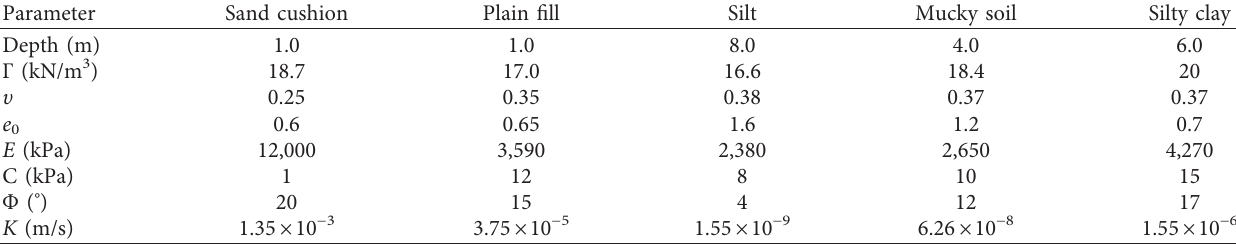
Table 1: Basic physical parameters of the soil